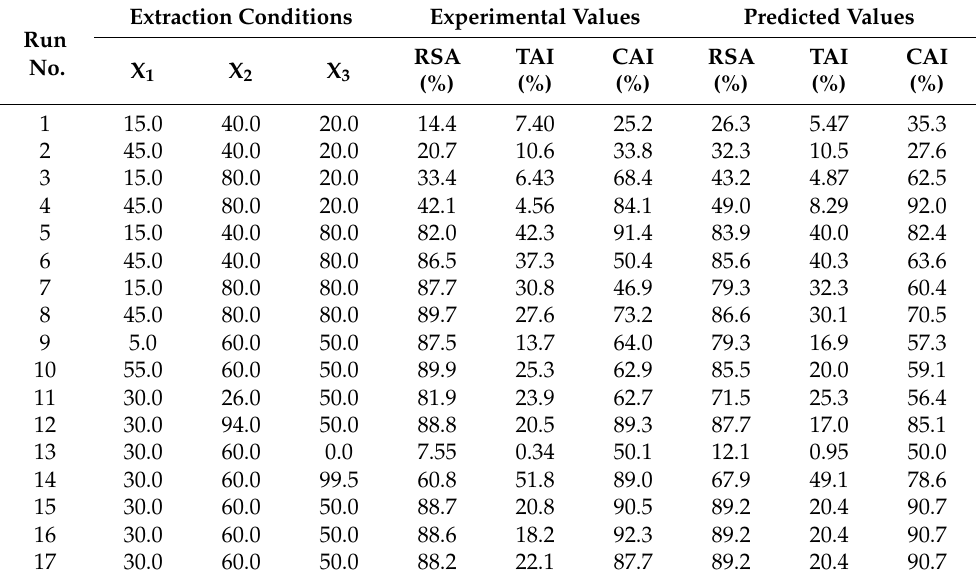
Table 2. Experimental and predicted data on radical scavenging activity (RSA), TAI, and CAI of peanut shell extract by CCD.